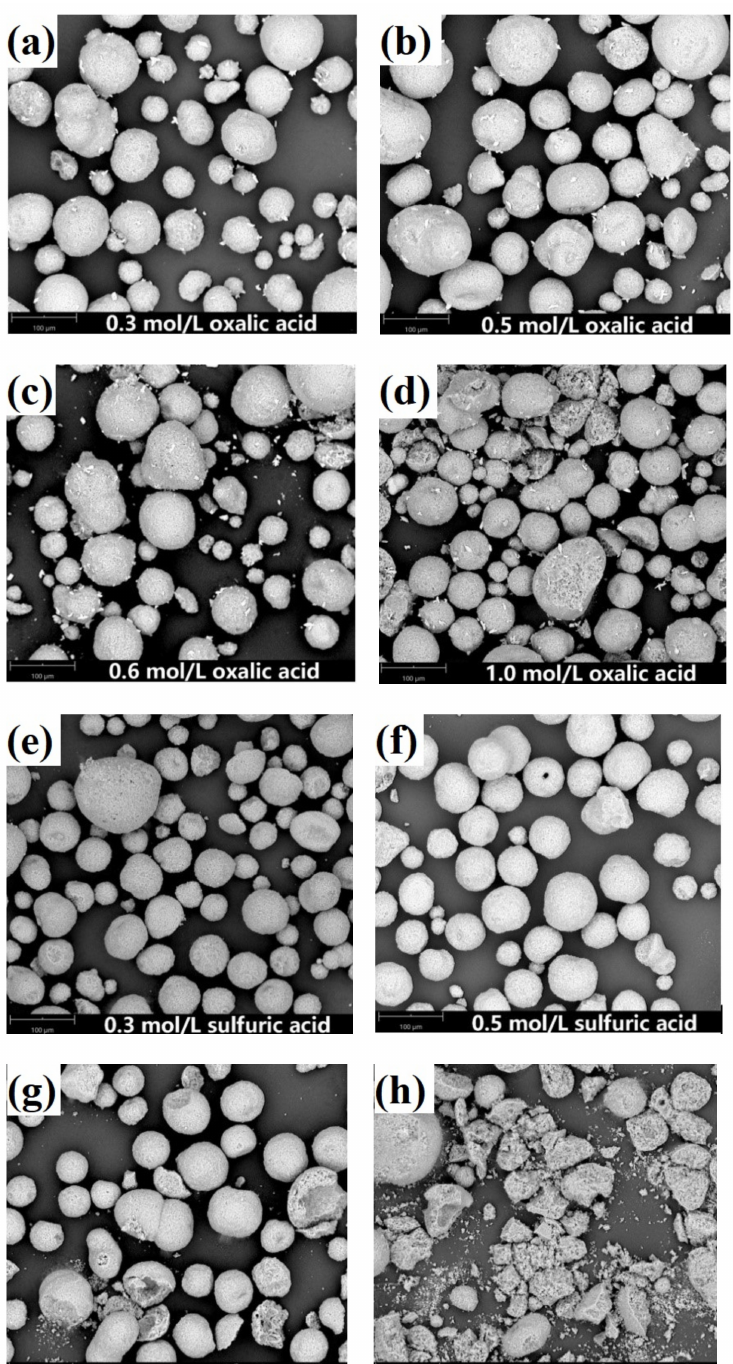
Figure 5. SEM images of leaching residue obtained with different acid concentrations. ( a ) 0.3 mol/L oxalic acid, ( b ) 0.5 mol/L oxalic acid, ( c ) 0.6 mol/L oxalic acid, ( d ) 1.0 mol/L oxalic acid, ( e ) 0.3 mol/L sulfuric acid, ( f ) 0.5 mol/L sulfuric acid, ( g ) 0.6 mol/L sulfuric acid, ( h ) 1.0 mol/L sulfuric